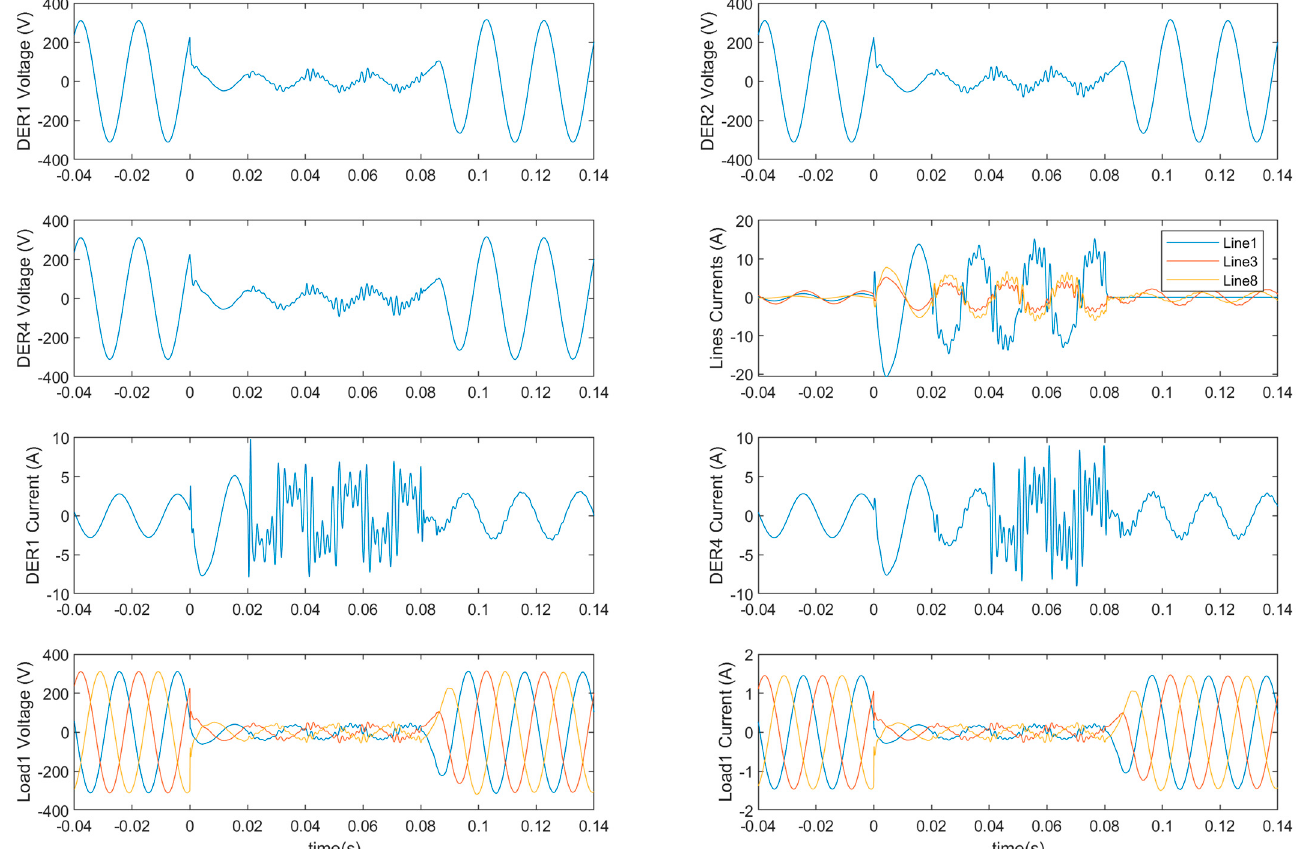
Figure 5. Simulation results for a three-phase short circuit fault in line 1.